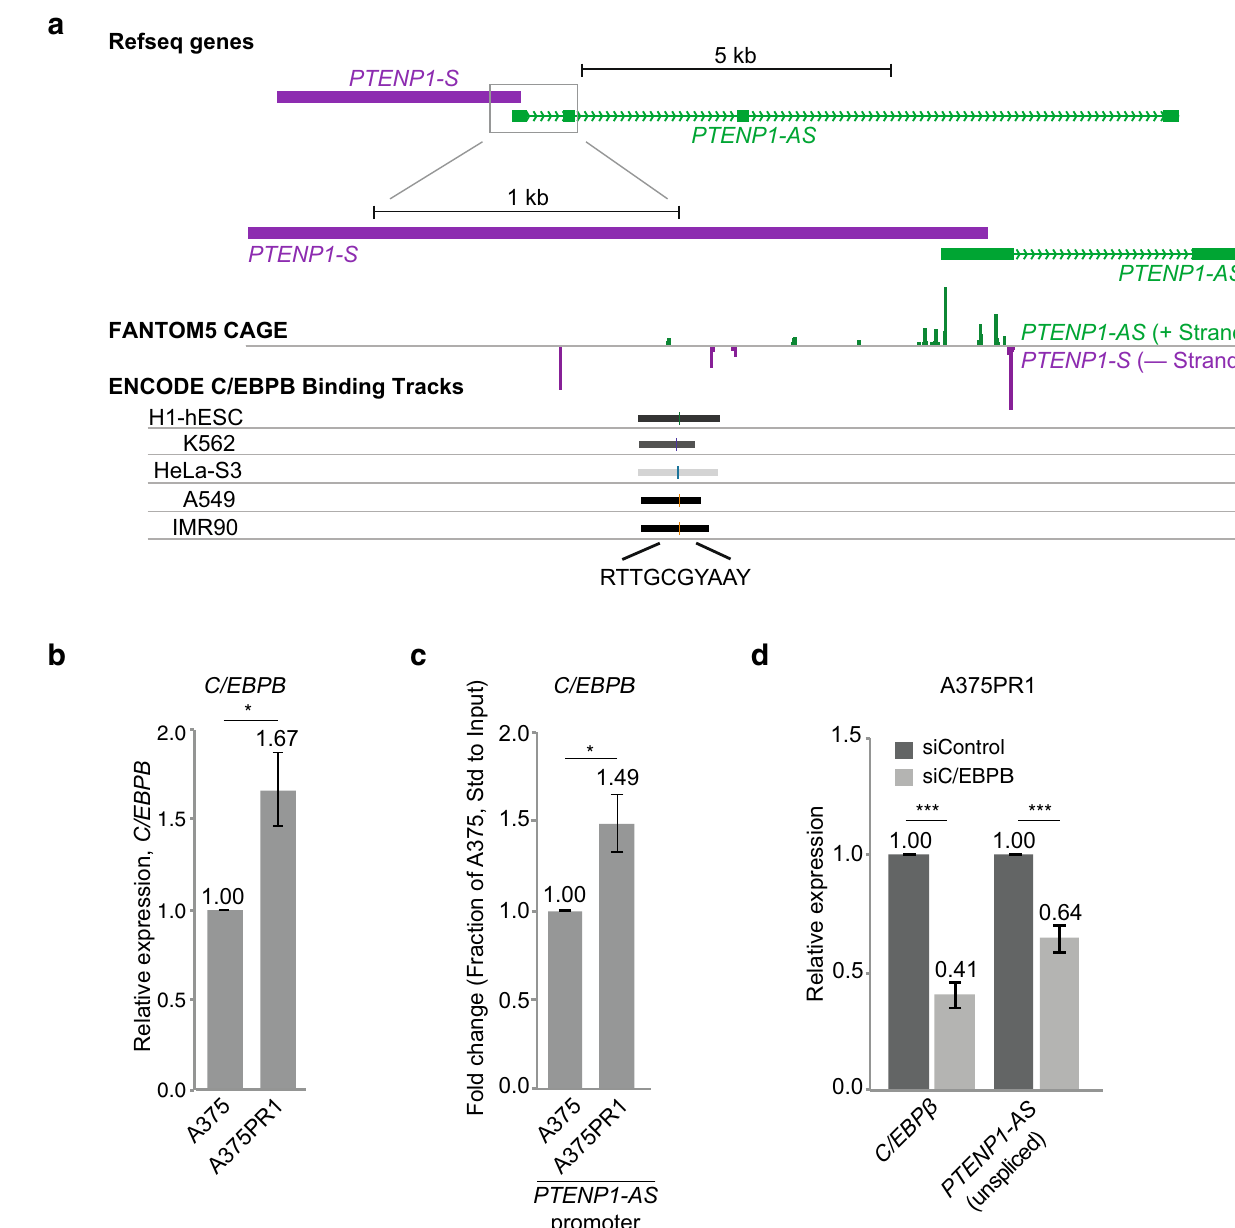
Figure 4. Transcriptional regulation of PTENP1-AS by C/EBPB. ( a ) A scheme showing binding of C/EBPB at the PTENP1 locus (data retrieved from the Zenbu FANTOM5 CAGE and the UCSC genome browser) and the predicted DNA binding site for C/EBPB (R is an A/G, Y is C/T). ( b ) qRTPCR measuring the expression levels of C/EBPB (n > 3). ( c ) ChIP followed by qRTPCR analysis measuring the levels of C/EBPB at the PTENP1-AS promoter (n = 3). ( d ) qRTPCR measuring expression levels of C/EBPB and unspliced PTENP1-AS in A375PR1 cells upon siRNA-induced knockdown of C/EBPB (n =